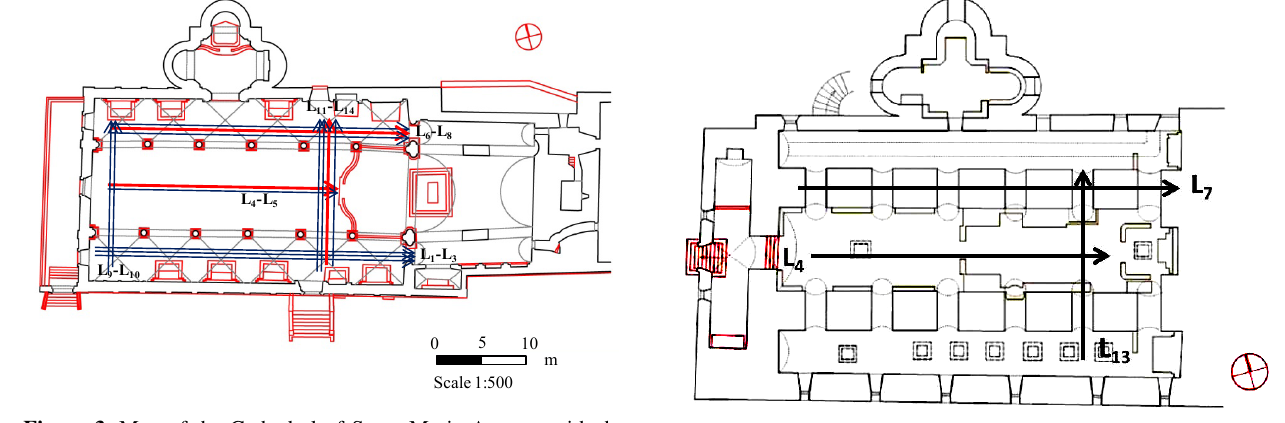
Figure 3. Map of the Cathedral of Santa Maria Assunta with the layout of the gathered B-scans.